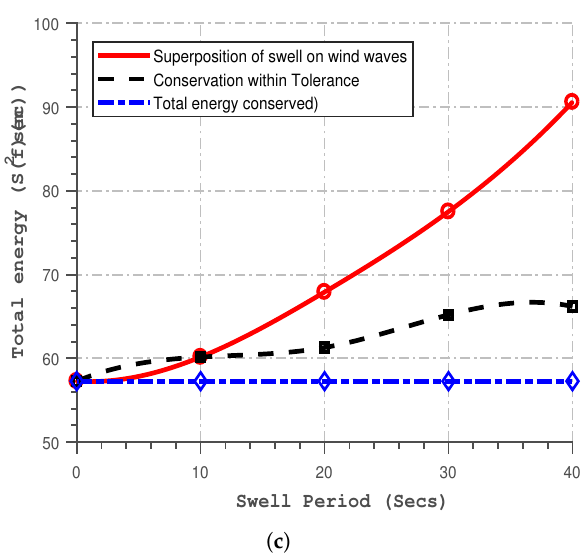
Figure 5. Comparison of the different free surface elevations for different swell percentages at swell peak period of 25 s. ( a ) Free surface elevation obtained for different swell percentages as shown; ( b ) Analysis of the surface elevation shown in ( a ) above; ( c ) Comparison of total energy obtained for different methods of combining swell and